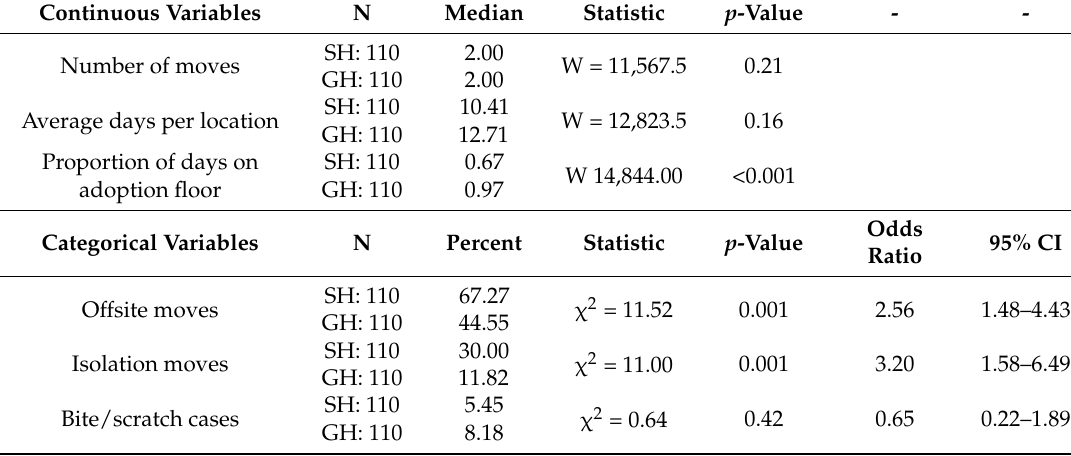
Table 1. Summary of measures relating to the cat’s experience. Single-housed (SH) cats spent less time on the adoption floor, and were move likely to be moved offsite and to the isolation unit than group-housed (GH) cats.